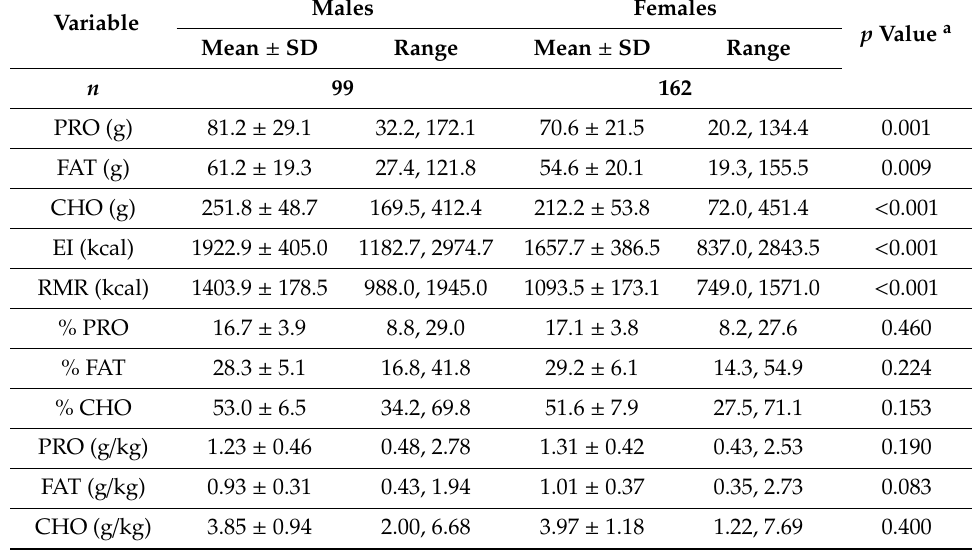
Table 2. Daily macronutrient intake, energy intake, and energy expenditure (mean ± SD and range) of the study